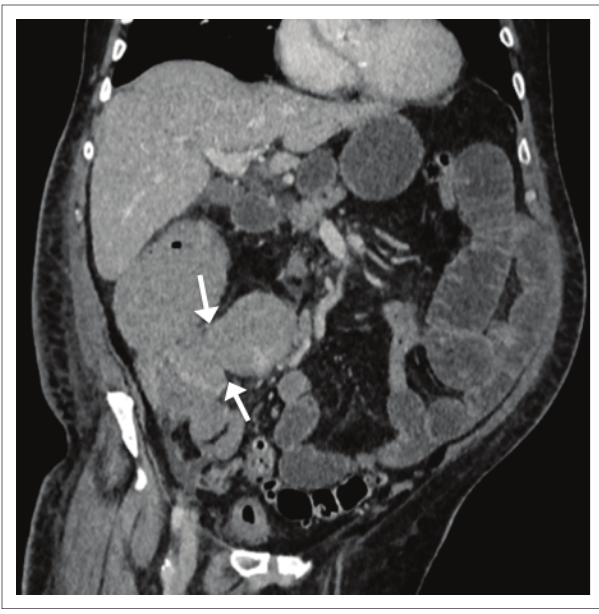
CT, computed tomography. FIGURE 3: Axial reconstruction of portovenous phase–enhanced CT, demonstrating circumferential mural thickening of the sigmoid colon